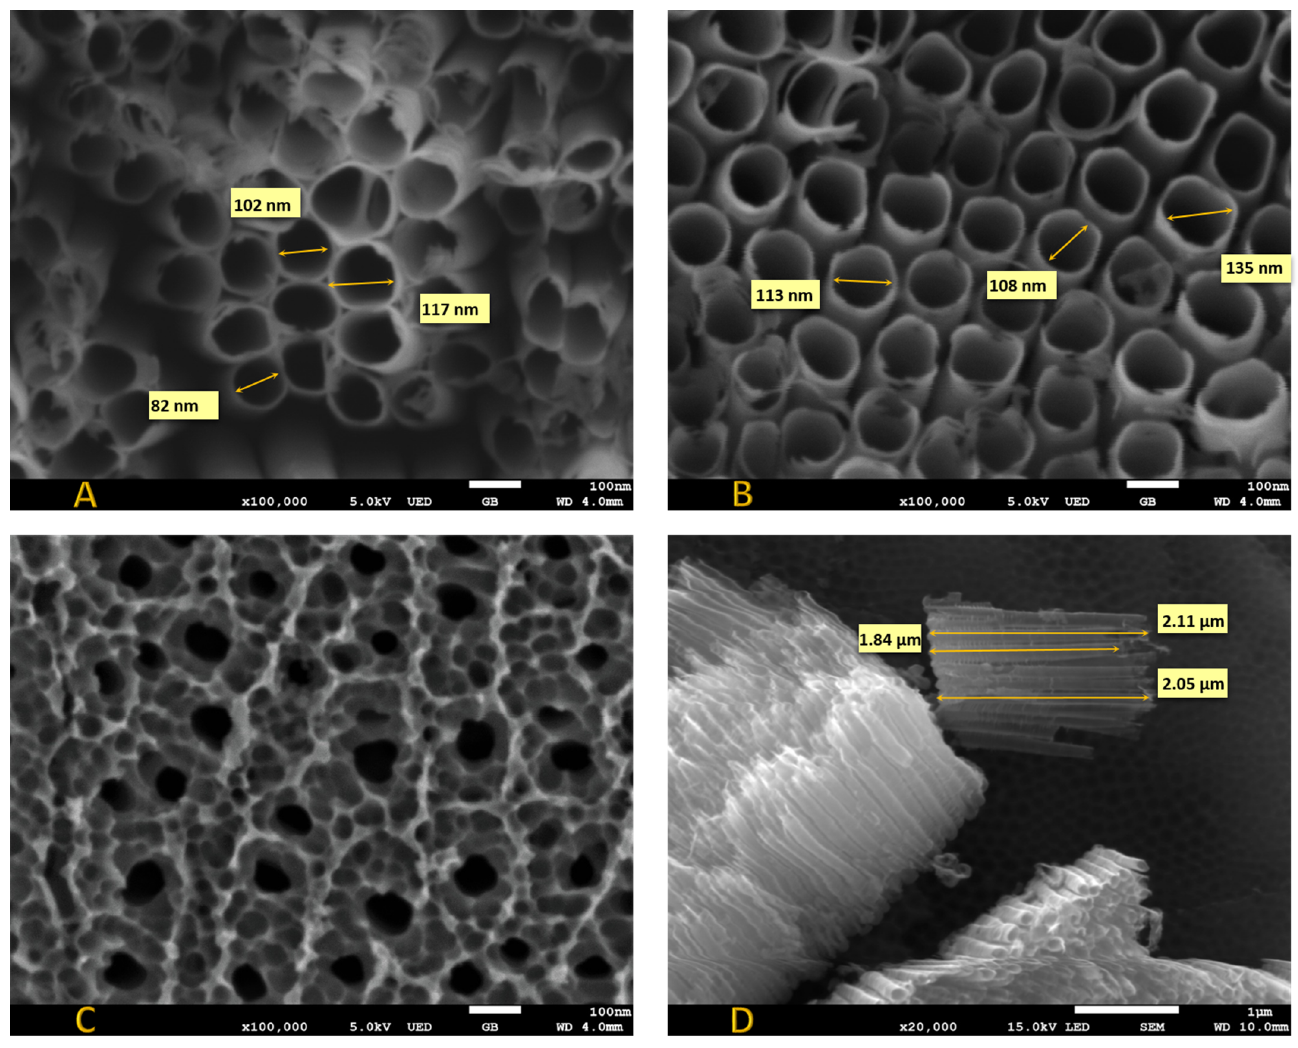
Figure 1. SEM images: ( A ) pure TiO 2 nanotubes TiO 2 -NTs; ( B ) sample hydrothermally modified Co-TiO 2 -NTs; ( C ) sample Co-TiO 2 after final thermal treatment (450 °C, 2 h); and ( D ) length of nanotubes for Co-TiO 2 -NTs.